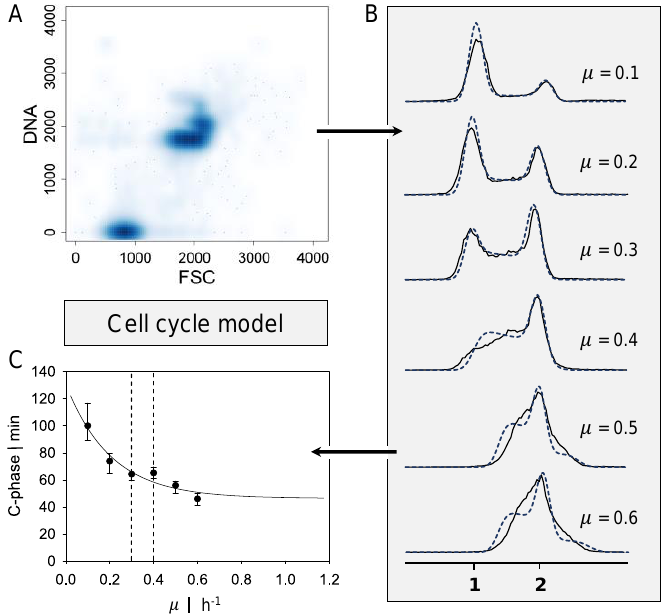
Figure 1. Approach for the cell cycle dynamics model. ( A ) Representative flow cytometry scatter plot for deoxyribonucleic acid (DNA) content of the growth rate µ = 0.3 h − 1 . ( B ) DNA content over counts for growth rates ranging from µ = 0.1 h − 1 up to µ = 0.6 h − 1 . A single genome is indicated by 1, and double chromosomes by 2. Black lines present experimental data, and blue dashed lines present the calculation of the cell cycle model. ( C ) Approximated C-phase duration over growth rate estimated by the cell cycle model (1% parameter covariance). Black dashed lines indicate the transition regime from single-forked to multiforked replication. Flow cytometry data obtained by Lieder et al. [6].